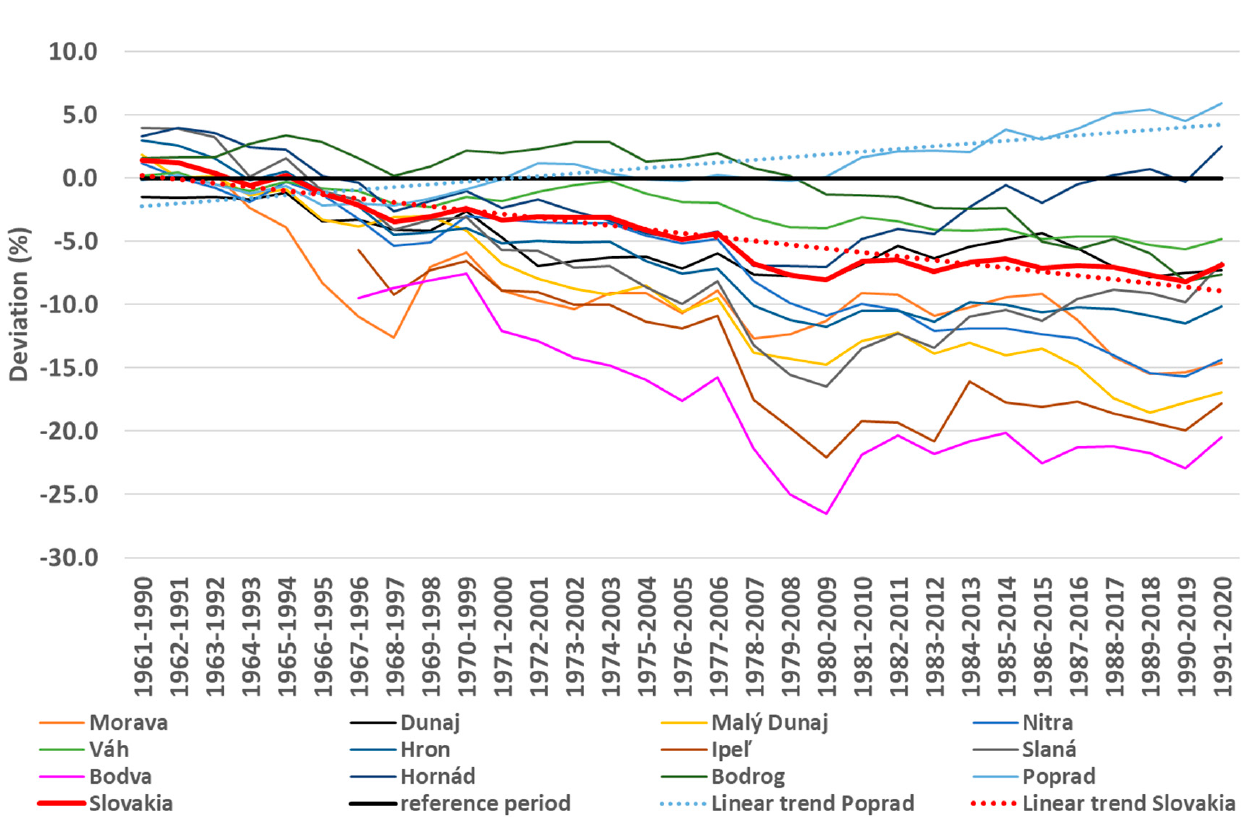
Figure 4. The course of 30-year moving values of the average deviations (%), reference period 1961–2000.